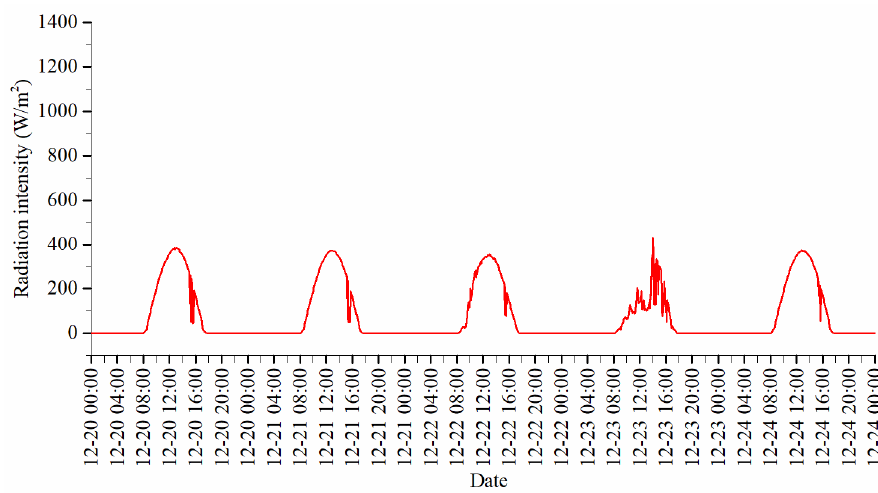
Figure 16. Selection of optimum days for winter illumination.